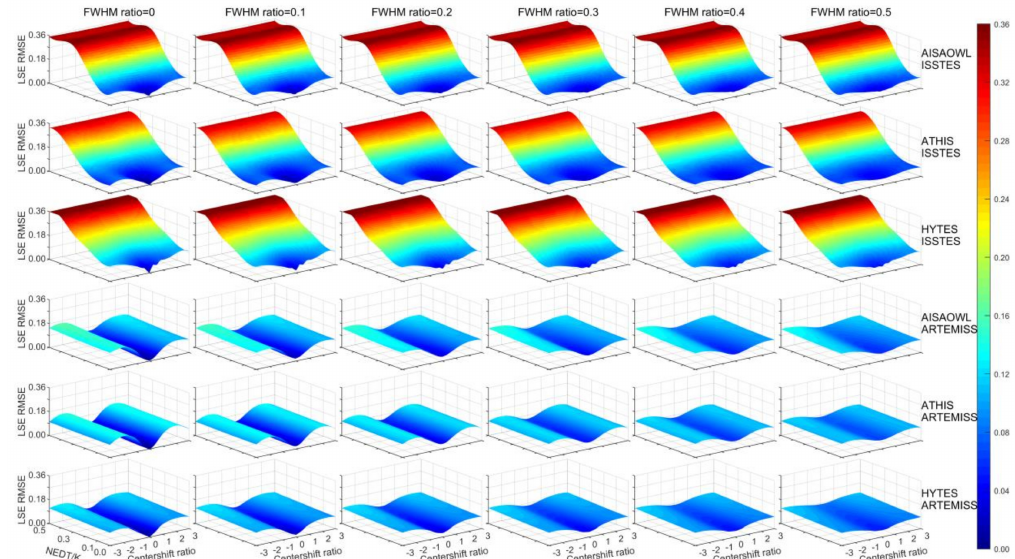
Figure 4. Distribution trend of the retrieval LSE errors with the center wavelength shift ratios, FWHM change ratios and NEDTs. The sub-images have a same coordinate system with consistent axis ranges and color bar, where the X axis on the right hand side is the center wavelength shift ratio, the Y axis on the left hand side is instrument noise NEDT (K), the Z axis is the LSE RMSE, and the color is proportional to the error. Each sub-image has a constant the FWHM change ratio. 1–3 rows: LSE errors of AISAOWL (100 nm), ATHIS (50 nm) and HYTES (35 nm) inversed by ISSTES respectively; 4–6 rows: LSE errors of AISAOWL (100 nm), ATHIS (50 nm) and HYTES (35 nm) inversed by ARTEMISS